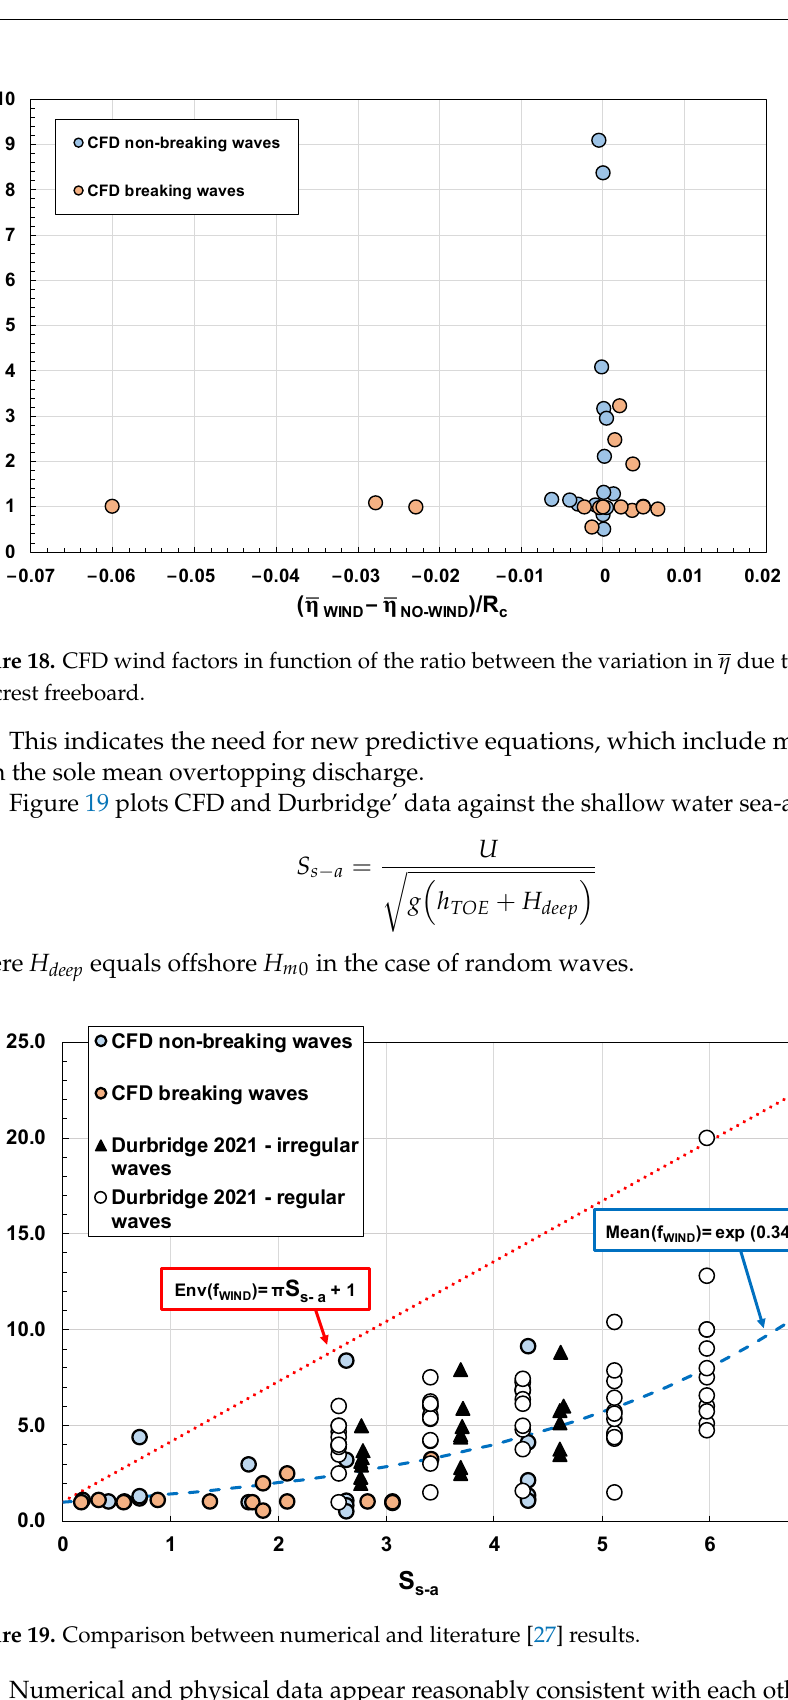
21 of 26 Figure 17. Comparison between numerical and physical f WIND trends [5].